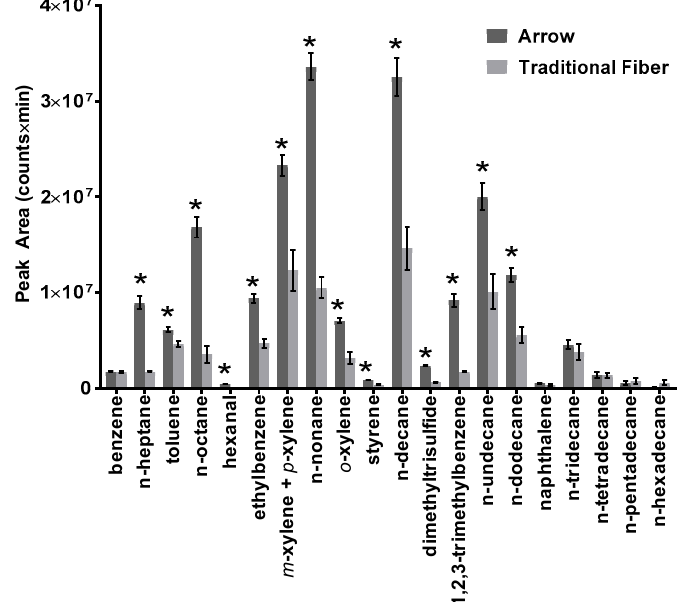
Figure 3. Comparison data for the carbon wide range (CWR)/polydimethylsiloxane (PDMS) fiber using the volatiles reference mix (VRM) 3 and the saturated alkanes mix (SAM) 3. Error bars represent standard deviation based on n = 3 samples. Fibers in both categories were exposed at room temperature for 5 min and analyzed using the same GC–MS method. Statistical significance (*) was determined using the multiple t-test option, correcting for multiple comparisons using the Holm–Sidak method with α = 0.05. Each compound was analyzed individually, without assuming a consistent standard deviation.